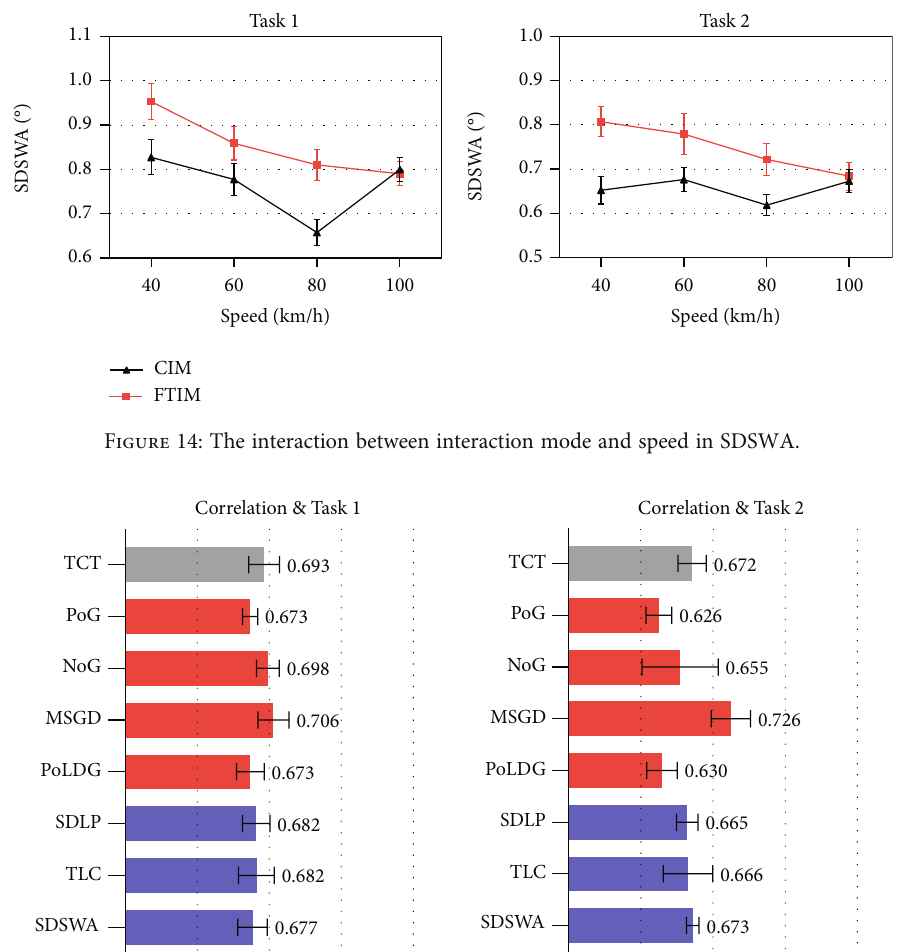
Figure 15: Correlation coe ffi cients of each metric in the two interaction